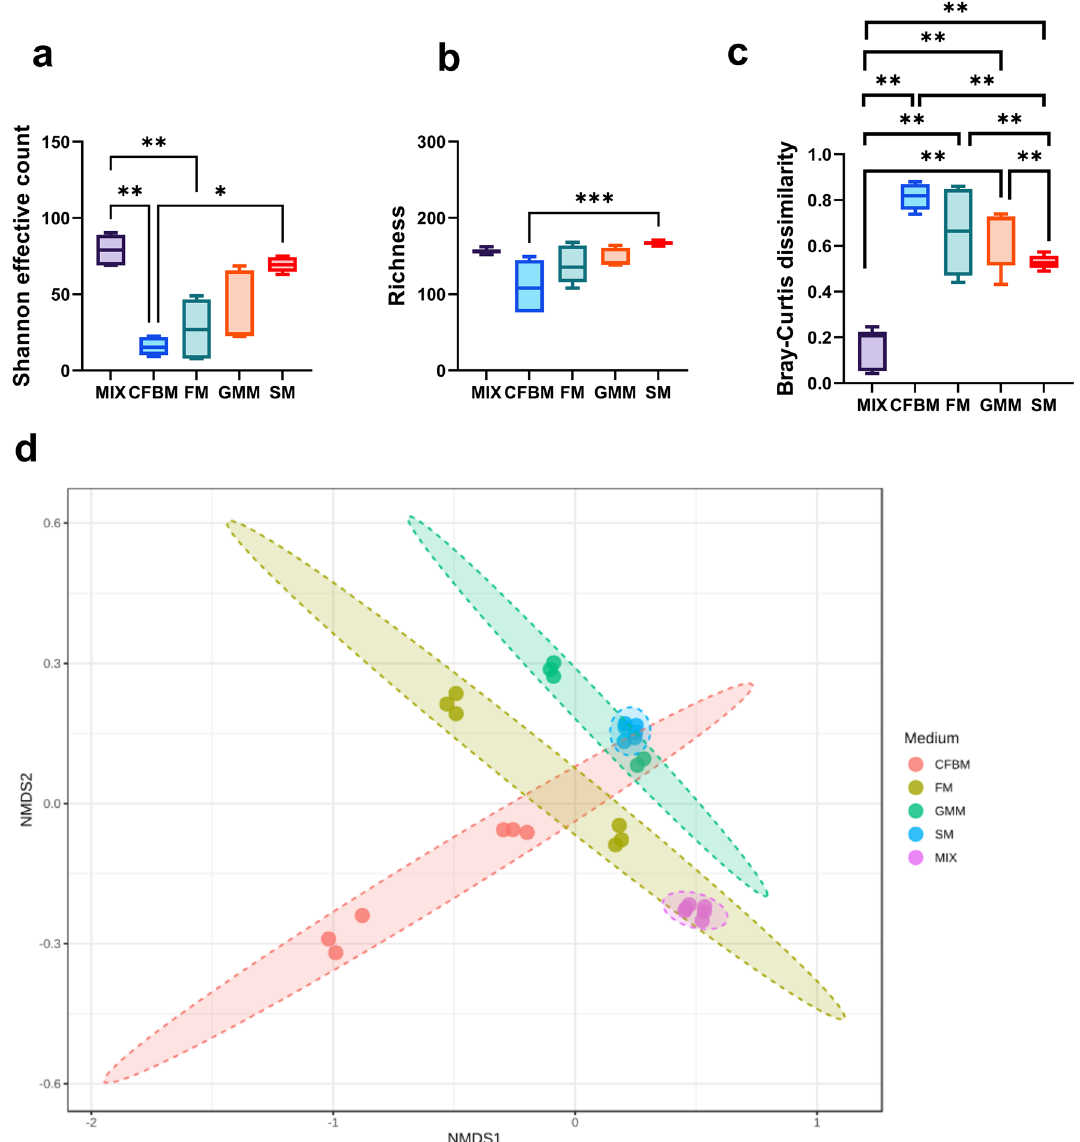
Figure 2. Community α -diversity is shown as ( a ) Shannon effective counts and ( b ) Richness of the GM after 24 h of cultivation in four different media: CFBM, FM, GMM, and SM compared to the non-cultured MIX inoculum (n = 6). The β -diversity analysis is shown as ( c ) Box plots showing Bray–Curtis distances between microbial communities. ( d ) NMDS plot based on the Bray–Curtis distances metric (R 2 : 0.70263; p = 0.001; NMDS stress = 0.0548). Ellipses were drawn based on the 95% confidence interval for each group. Samples represent viable bacteria after PMA